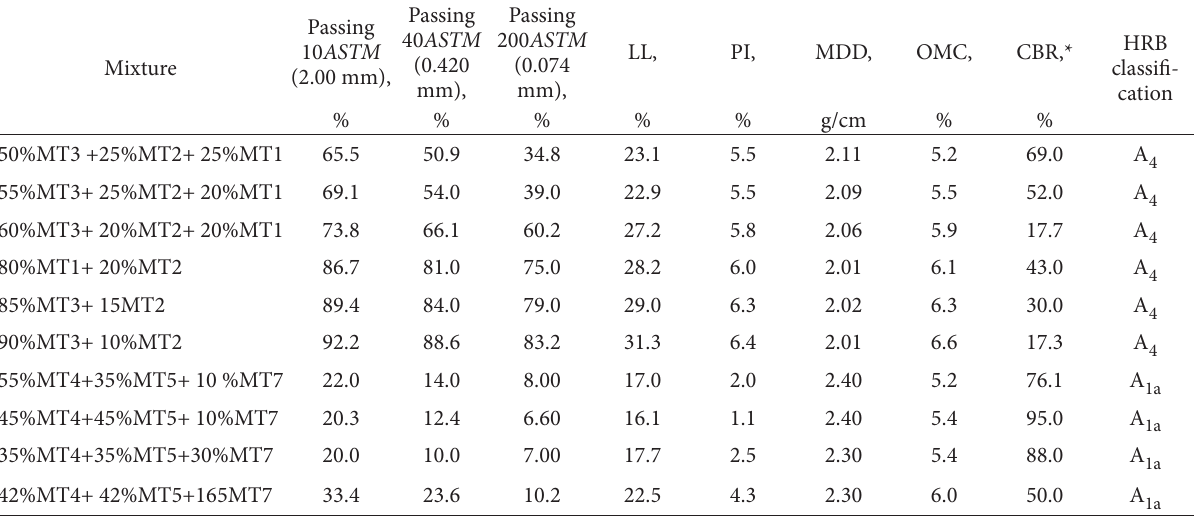
Table 2. Results of the standard laboratory test for designed mixtures